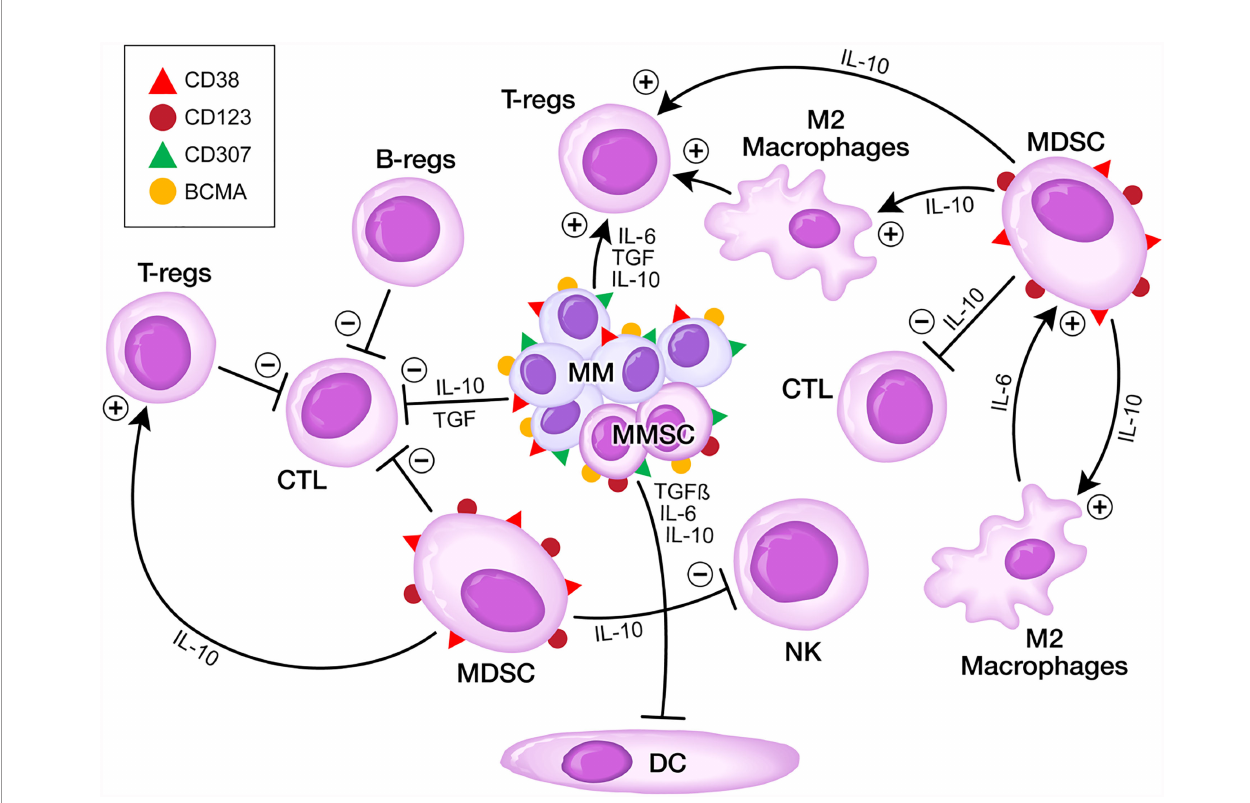
FIGURE 1 | Targeting the Immunosuppressive TME in MM. MM stem cells (MMSC) express BCMA, CD38, CD307 and CD123 antigens on their surface. MDSCs express CD38 and CD123 antigens on their